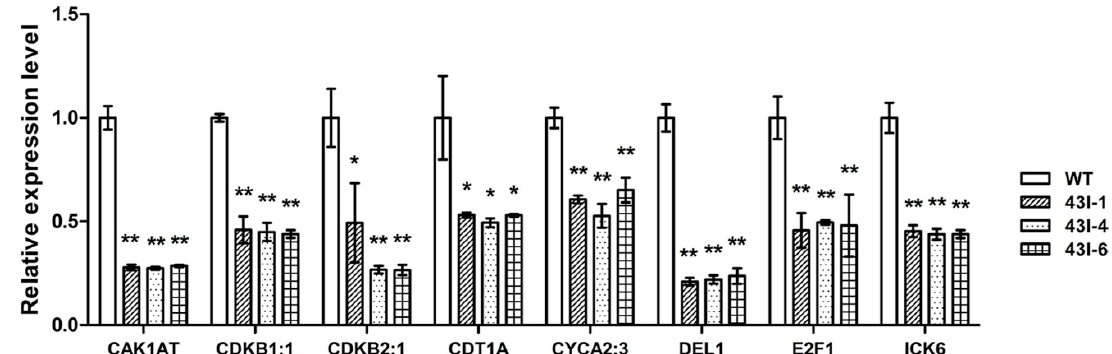
Figure 6. The expression patterns of genes related to cell cycle in the stem of oilseed rape after silencing BnMYB43 gene family. Expression level of each gene in WT was set as 1. Expression level of 25SrRNA was used as control reference. Values are means ± SD ( n = 3 biological replicates). Asterisks indicate significant or extremely significant differences from the control (*, 0.01 ≤ p < 0.05; **, p < 0.01) using one-way ANOVA.